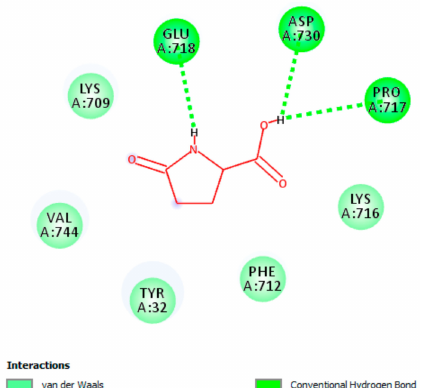
Figure 4. A two-dimensional illustration shows pyroglutamic acid (pGlu) binds to the catalytic pocket of Jack bean urease. Essential hydrogen bonding interactions along with van der Waals interactions with residues of the catalytic pocket, which are crucial for inactivating the enzyme, are